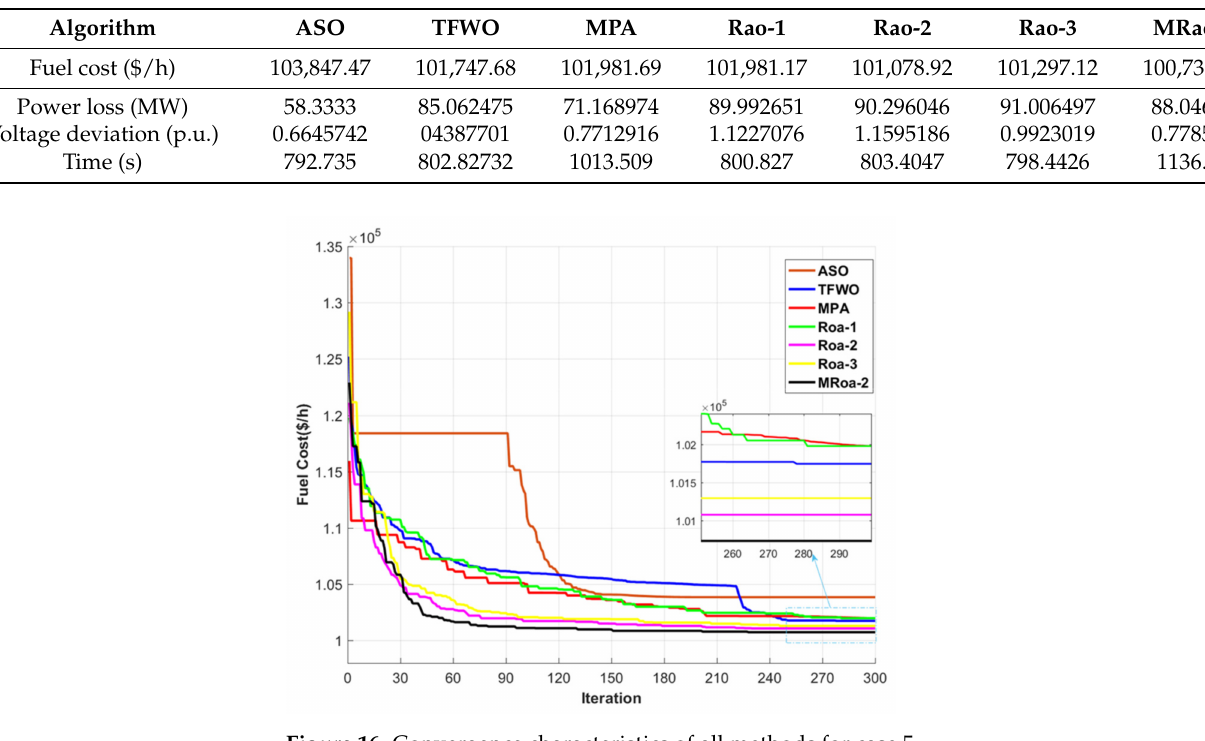
Figure 16. Convergence characteristics of all methods for case